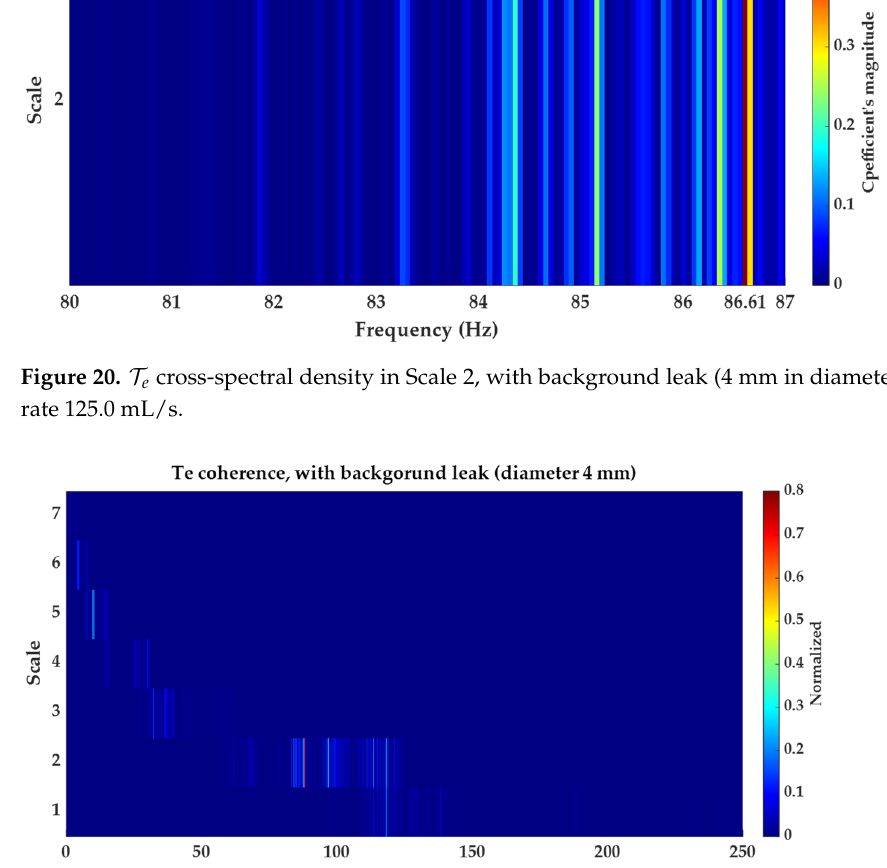
Figure 22. 𝒯 (cid:3032) coherence in Scale 2 , with background leak ( 4 mm in diameter) and flow rate 125.0 mL/s . These contributions allow the investigation of the relationship between two signals in the dyadic frequency domain. The main advantage they present is that they allow the